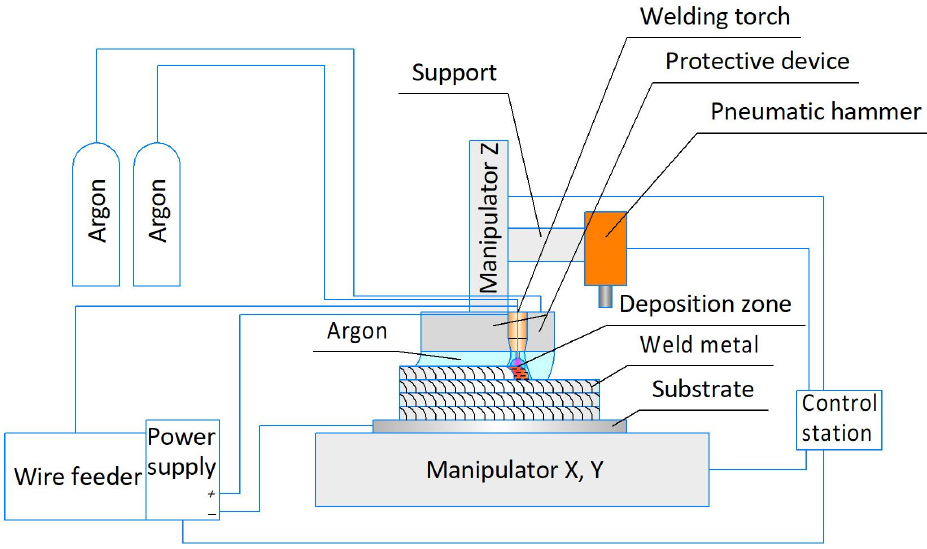
Materials 2021 , 14 , 4415 Figure 1. Diagram of the wire-arc three-dimensional consumable electrode deposition.